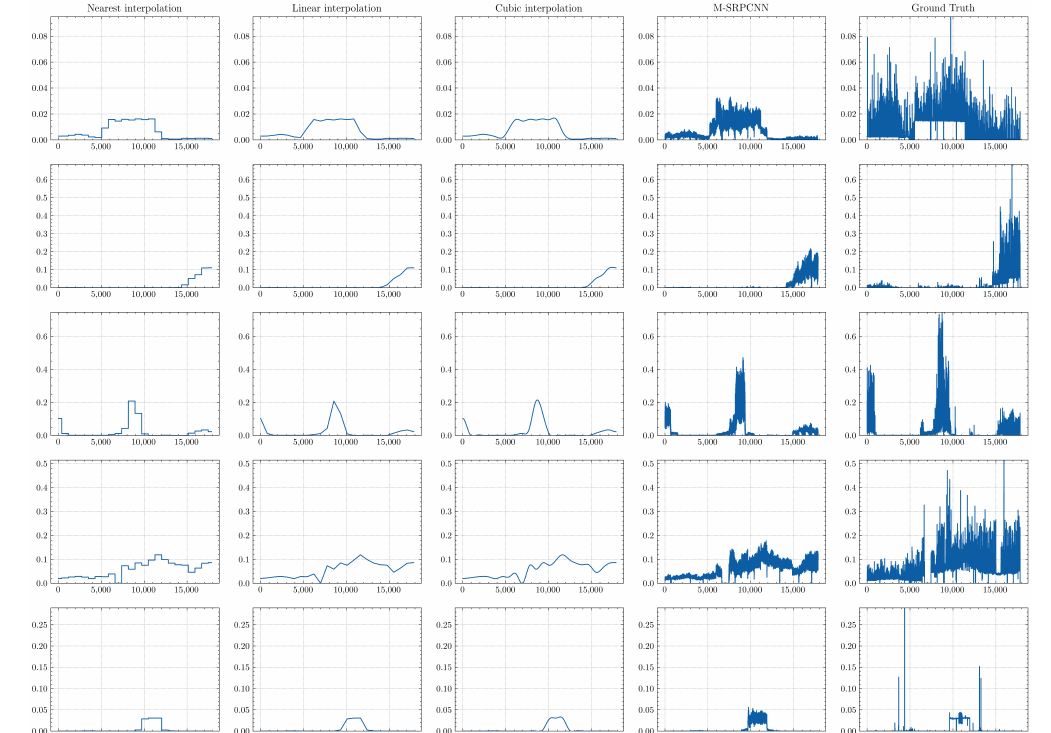
Figure 5. Comparison of SRP reconstructions using different interpolation methods and M-SRPCNN of random samples from the test set of SMARKIA SRP dataset.